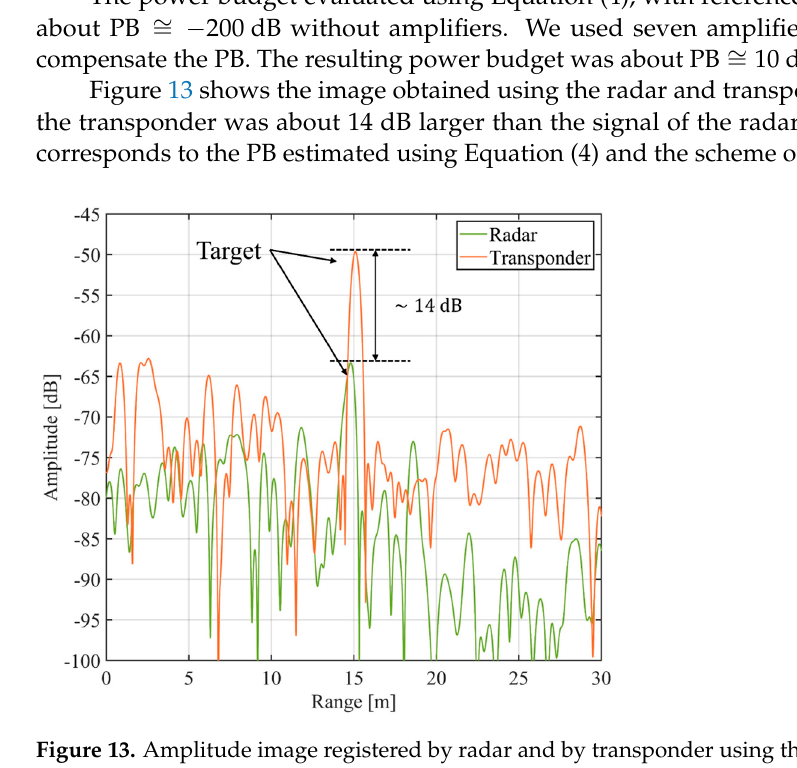
Figure 12. Experimental setup for verification of Equation (4): ( a ) picture of experimental setup, ( b ) block scheme used.